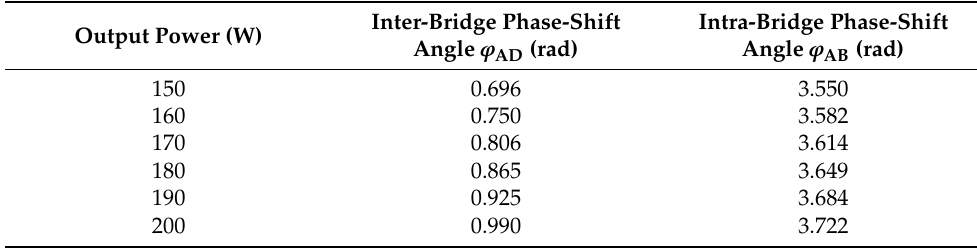
combination table.